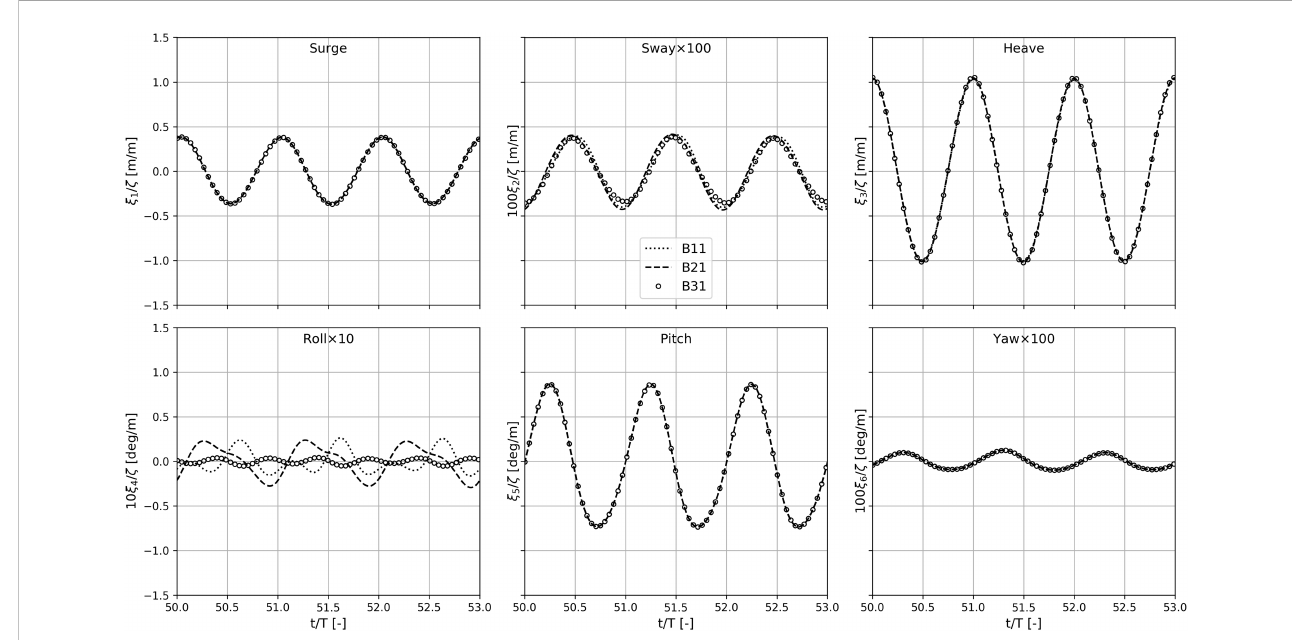
FIGURE 8 Time series of computed motions of the modules at R1 in a regular wave of w = 0.33